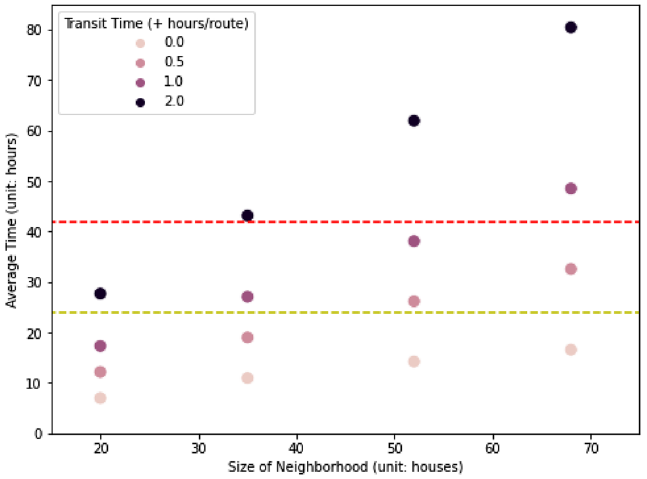
Figure 4. Trade-offs between size of neighborhood and average evacuation time. The y-axis is the average time across both algorithms and all vehicle capacities (passenger limit= 2, 4, 8, 16, 32, and 64 people per emergency vehicle). The red dashed line represents the 42-h window (54–12 h before tropical storm winds reach the coast) while the yellow dashed line represents the 24-h window (54–30 h before tropical storm winds reach the